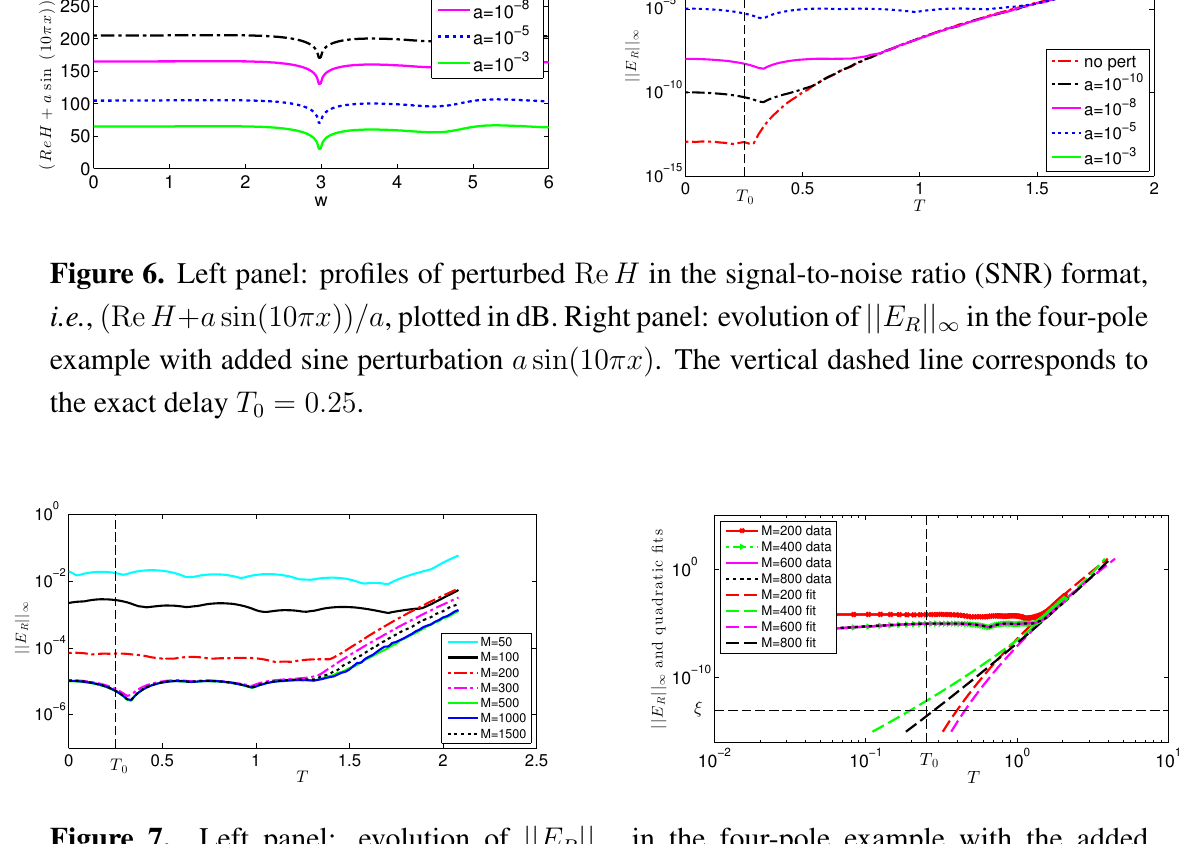
Figure 7. Left panel: evolution of || E perturbation 10 − 5 sin(10 πx ) . The dashed line corresponds to the exact delay T Right panel: error curves || E 10 − 5 sin(10 πx ) and M = 200 , 400, 600 and 800 together with their extrapolated quadratic fits. The vertical dashed line indicates the exact time delay T dashed line indicates the level of filtering of singular values given by ξ = 10 − 13